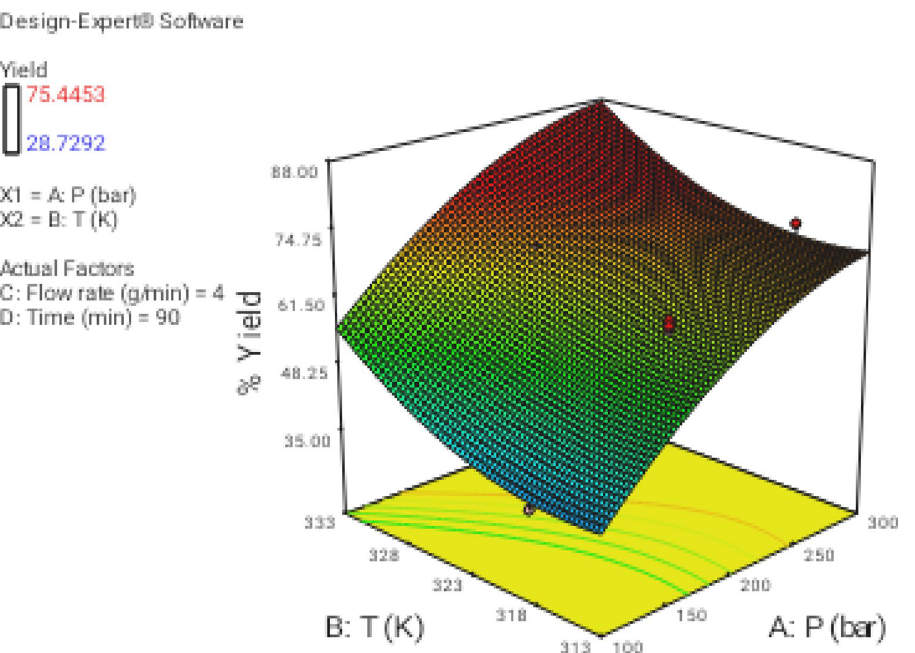
Figure 3. 3D graphic surface for the effects of temperature and pressure on the